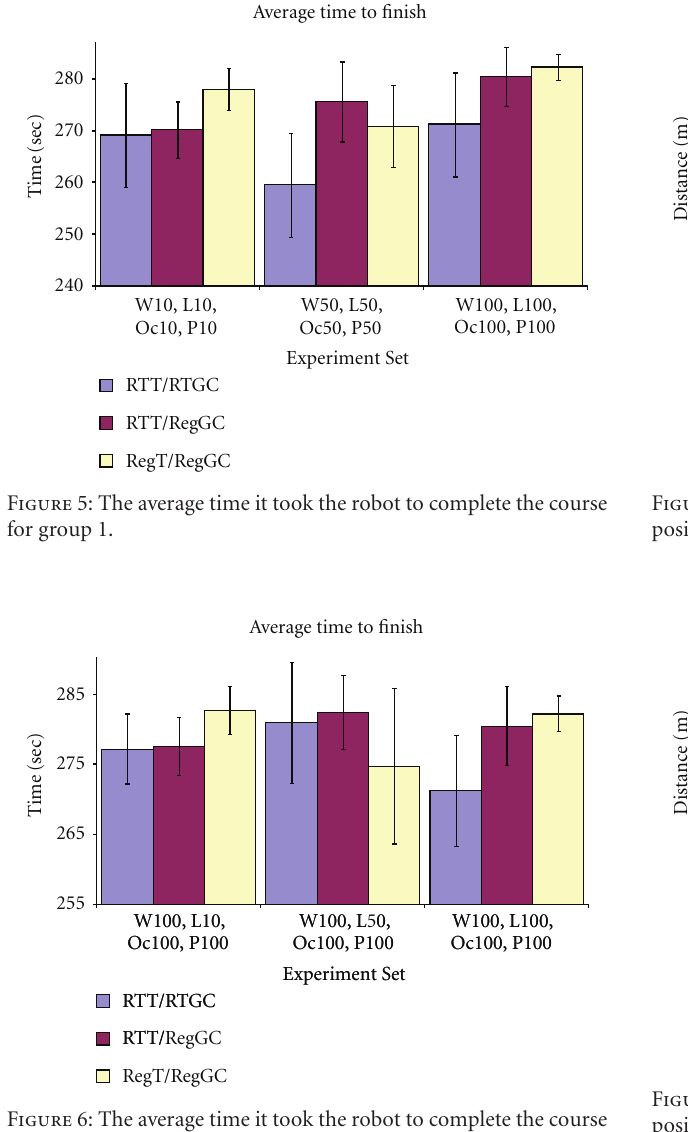
Figure 6: The average time it took the robot to complete the course for group 2.